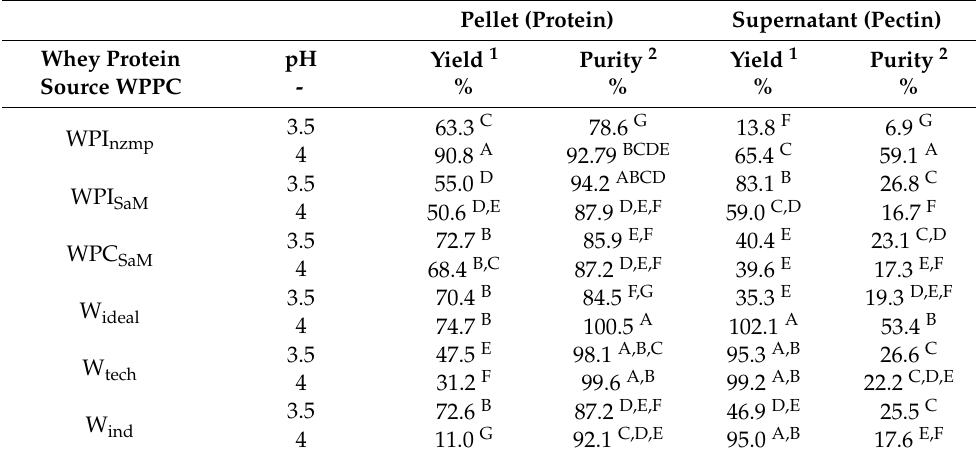
Table 3. Yield and purity of the pectin in the supernatant and protein in the pellet separated from dispersions of whey protein pectin complexes prepared using six different whey protein